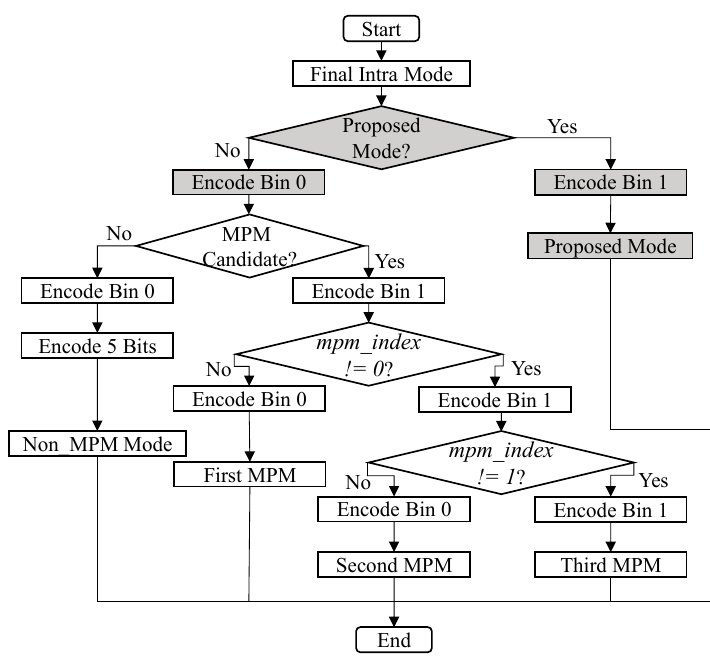
Figure 6. Illustration of the mode signaling for the luma modes.